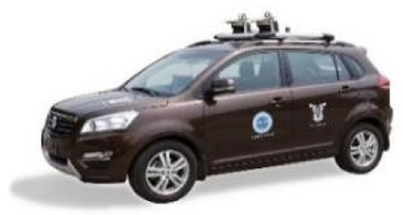
Figure 1. Unmanned vehicle with two 32-line lidars.